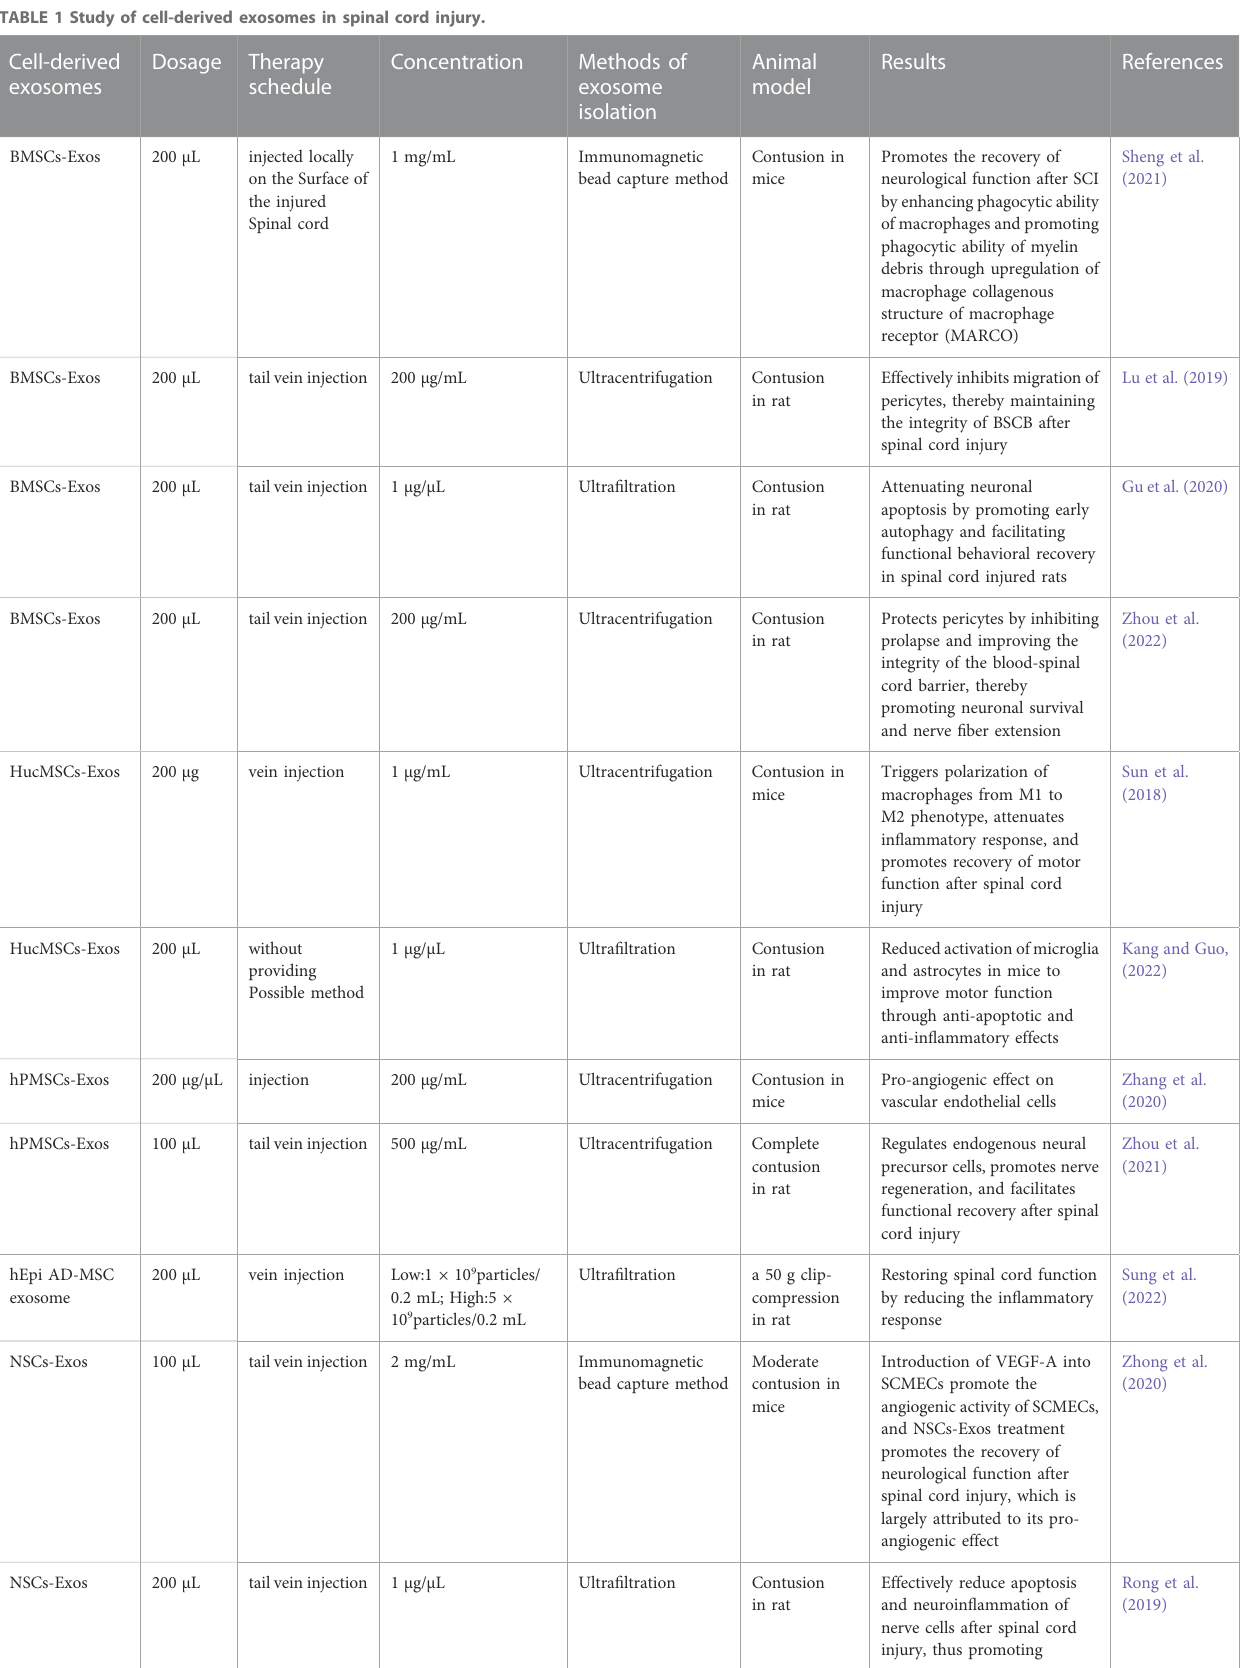
TABLE 1 Study of cell-derived exosomes in spinal cord